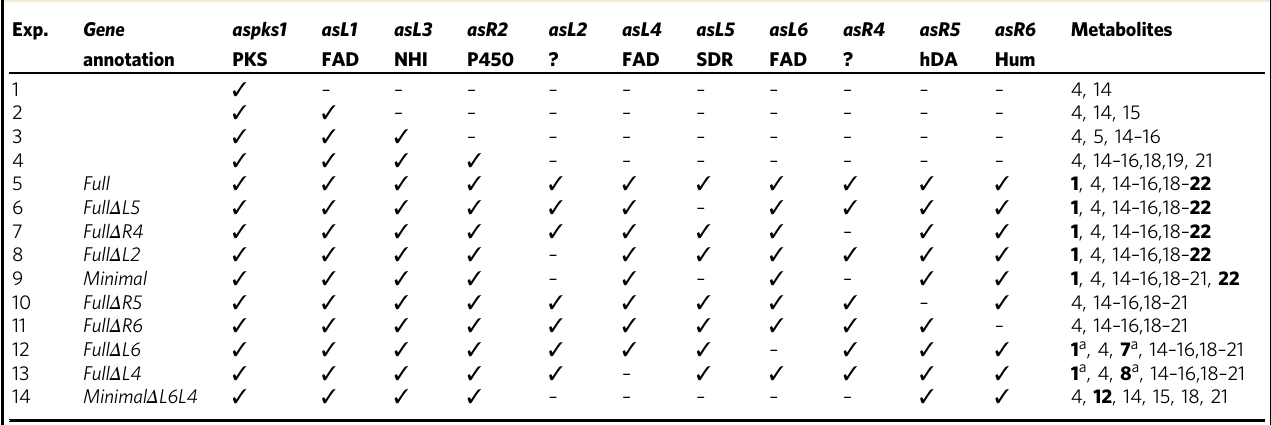
Table 2 Combinations of genes from the xenovulene BGC used for heterologous expression experiments in A. oryzae